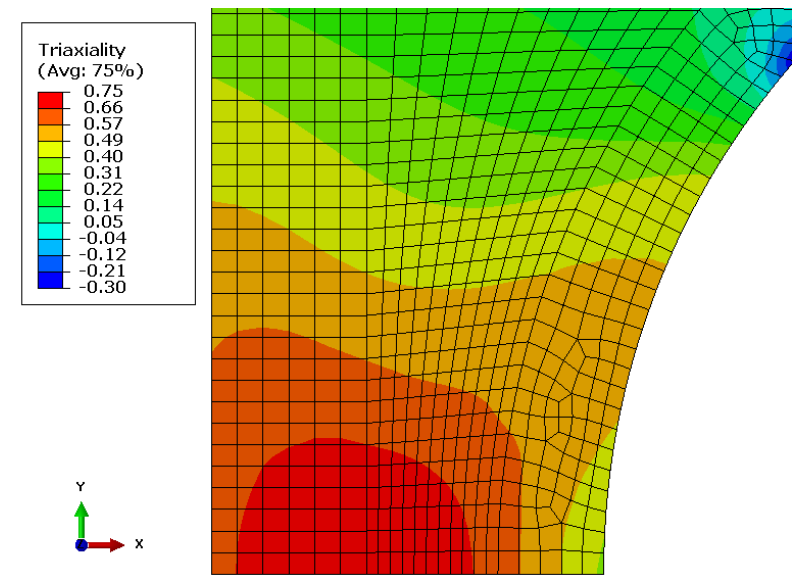
Figure 6. An overview of the stress triaxiality distribution in the deformation model around the onset of